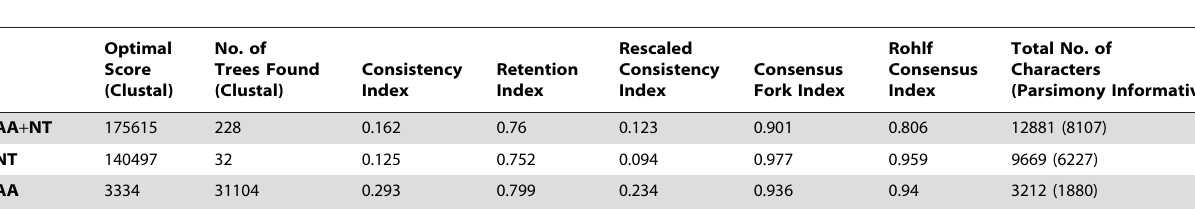
Table 1. Parsimony Tree